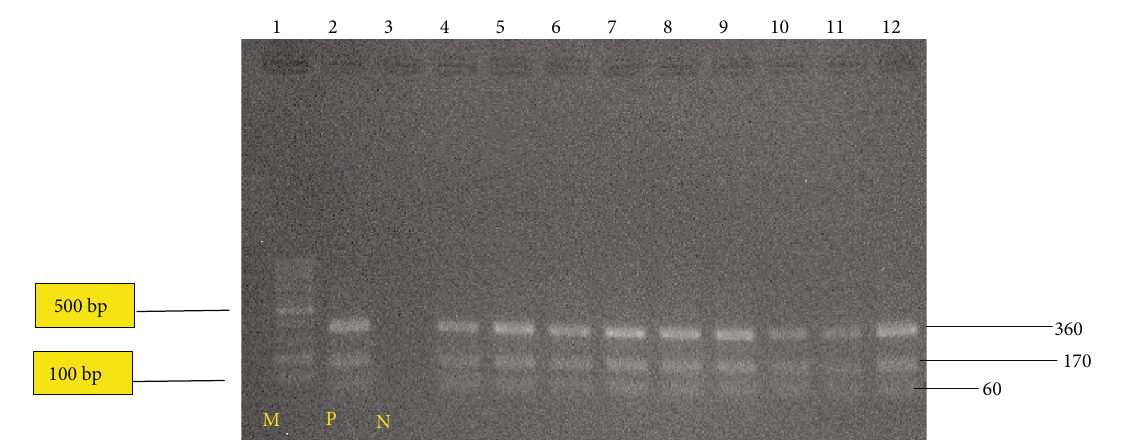
Figure 2: RFLP pattern of PCR product of liver fl uke collected from bovine in Shah Alam, Banting, Taiping, and Ipoh abattoirs after digestion with RsaI enzyme. Lane 1: 100 bp ladder molecular; lane 2: positive control; lane 3: the negative control; lanes 4 to 20: denoted to those of F. gigantica . The PCR product digested were run on 2% agarose gel at 100v for 60